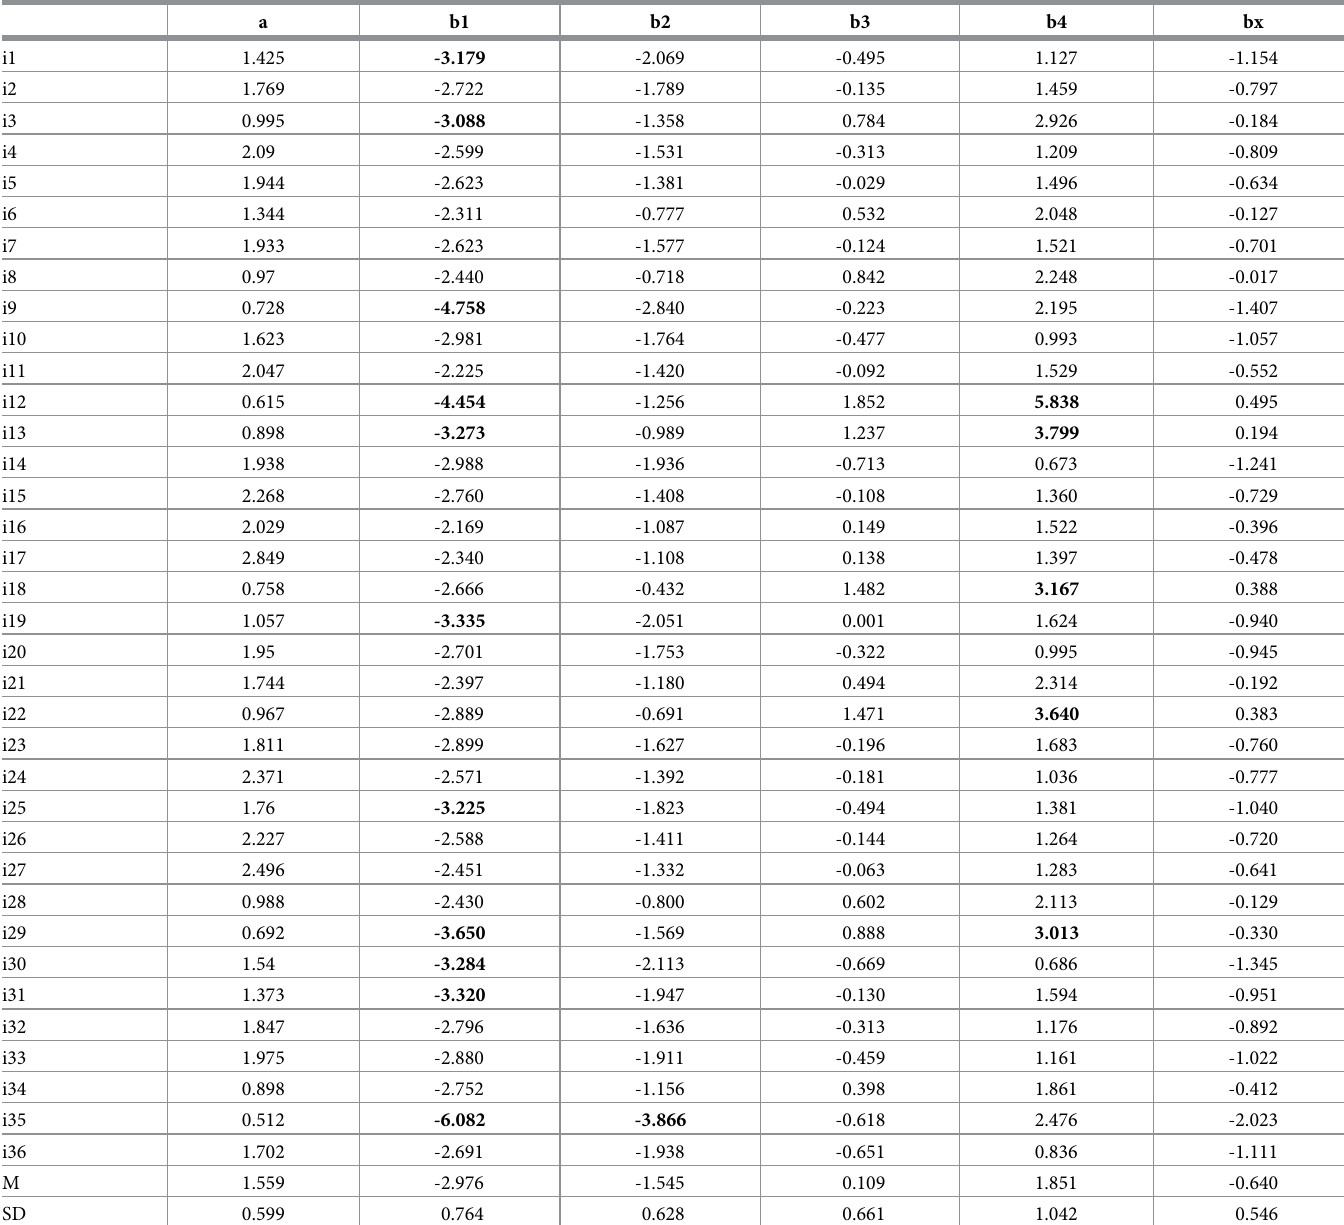
Table 7. Discrimination and difficulty item parameters for the